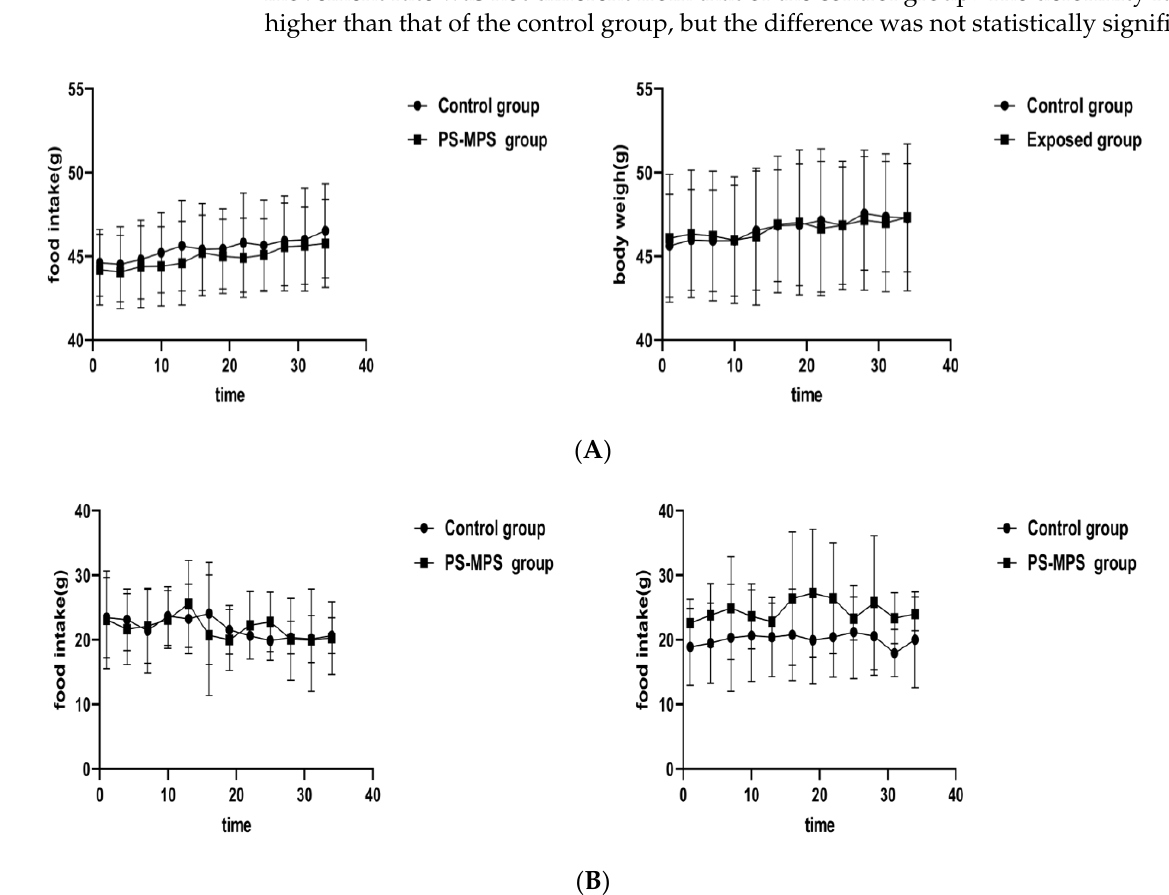
Figure 6. Body weight, food intake and organ coefficient of mice during the recovery period. The left side shows the change in the first recovery time and the right side shows the change in the second recovery time. ( A ) Body weight; ( B ) Food intake. The data are expressed as the mean ± SD (n = 8) and analyzed by dependent sample t -test. The left side of the figure shows the results of the first recovery period, and the right side shows the results of the second recovery period.